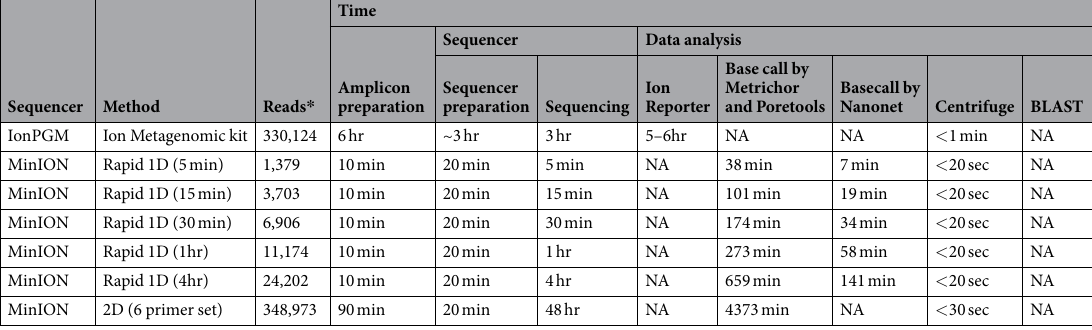
Table 1. Time scale of each protocol. * Number of fast5 files for MinION. Note that this does not necessarily mean reads